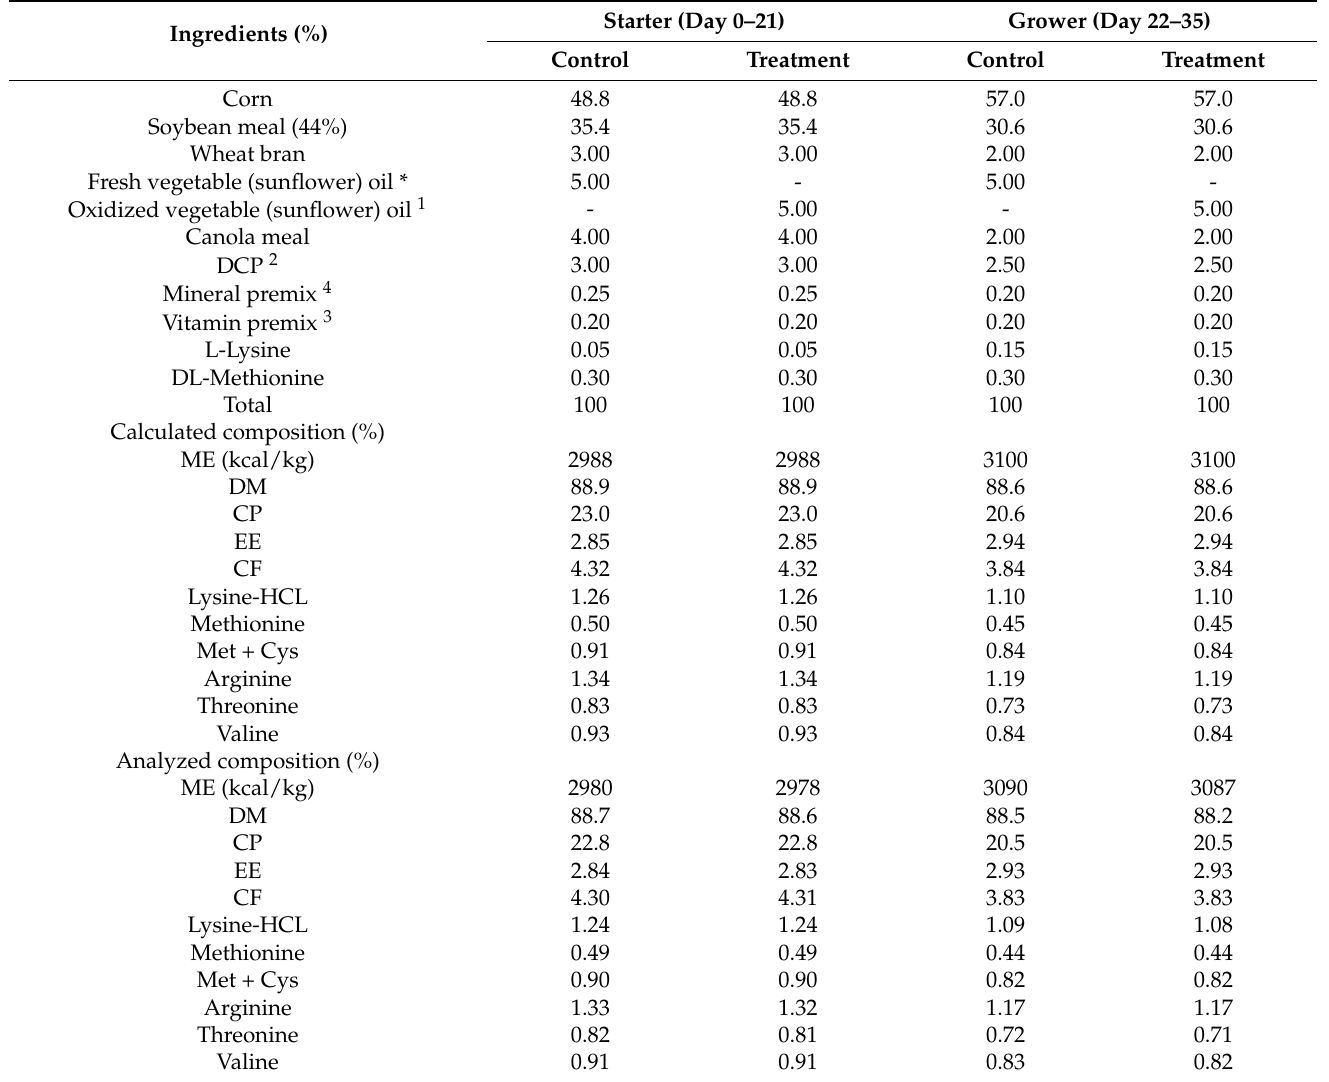
Table 6. Ingredients and nutrients composition of the experimental diets for broilers (as fed